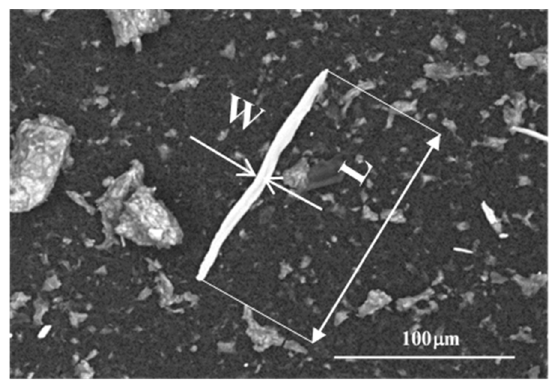
Figure 2. Definitions of determining the sizes of elongated inclusions.